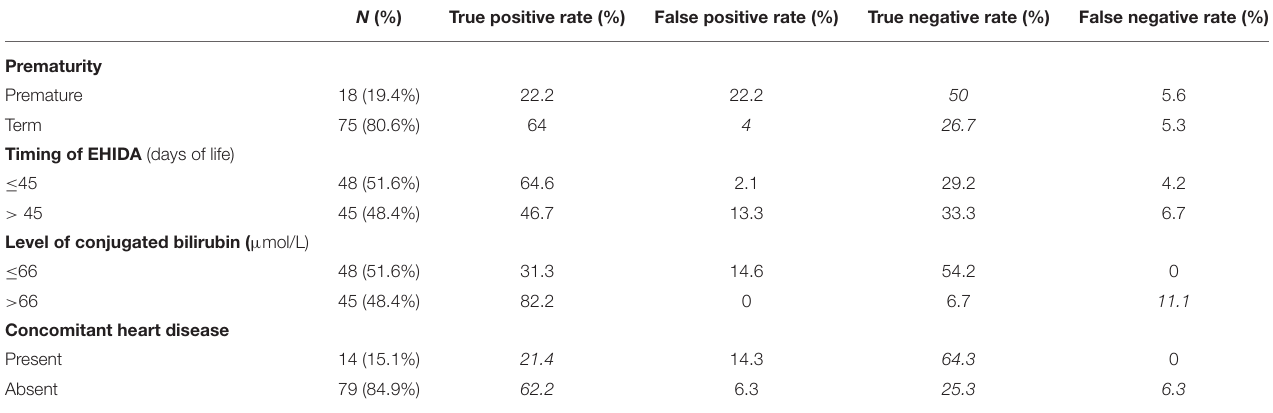
TABLE 2 | Diagnostic accuracy of EHIDA in the context of different variables (Prematurity, age of life to conduct EHIDA, conjugated bilirubin level and concomitant heart disease). N (%) True positive rate (%) False positive rate (%) True negative rate (%) False negative rate